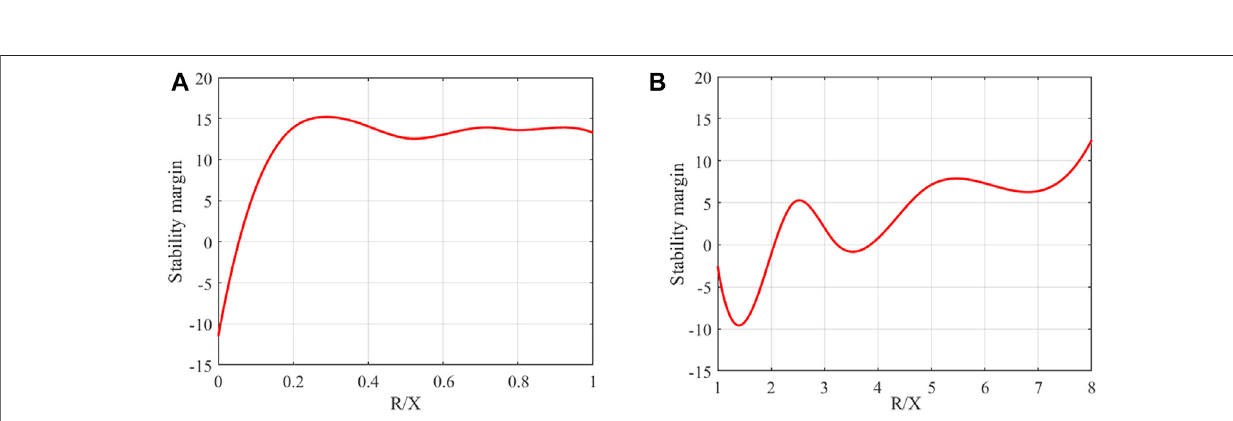
FIGURE 9 | Relationship between impedance ratio and stability margin (PV node): (A) R/X ratio is smaller than 1, (B) R/X ratio is larger than 1.